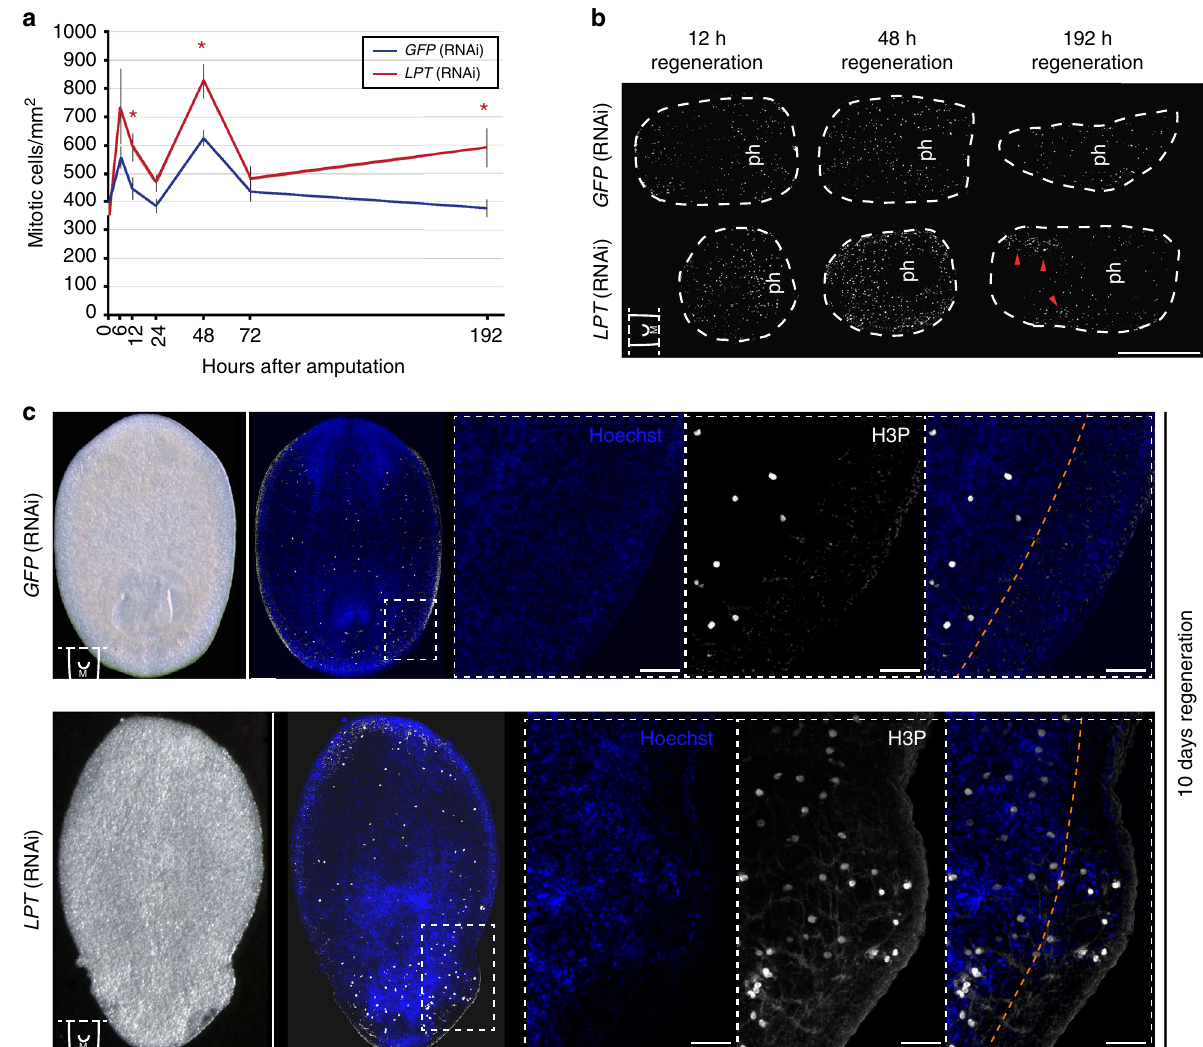
Fig. 4 Over-proliferation and mitotic cell clustering precedes and accompanies the emergence of outgrowths in LPT (RNAi) animals. a Quanti fi cation of mitotic cells (labeled by anti-H3P antibody) at different post-amputation time-points following LPT (RNAi). N = 10 animals per time-point. Two-tailed t -test was used for analysis; * p < 0.05. Error bars represent Standard Error of the Mean (SEM). b Examples of middle pieces at the time-points post-amputation showing signi fi cant difference in mitotic cell (white) counts according to ( a ). ‘ ph ’ indicates the pharynx. The red arrows point towards clusters of mitotic cells in late stage regenerates (192 h/8 days). Scale bar: 500 μ m. c Mitotic cells (white) are always restricted to mesenchyme tissue in GFP (RNAi) animals but penetrate into epidermal outgrowths in LPT (RNAi) animals. Orange line indicates the border of mesenchymal tissue. Scale bar: 50 μ